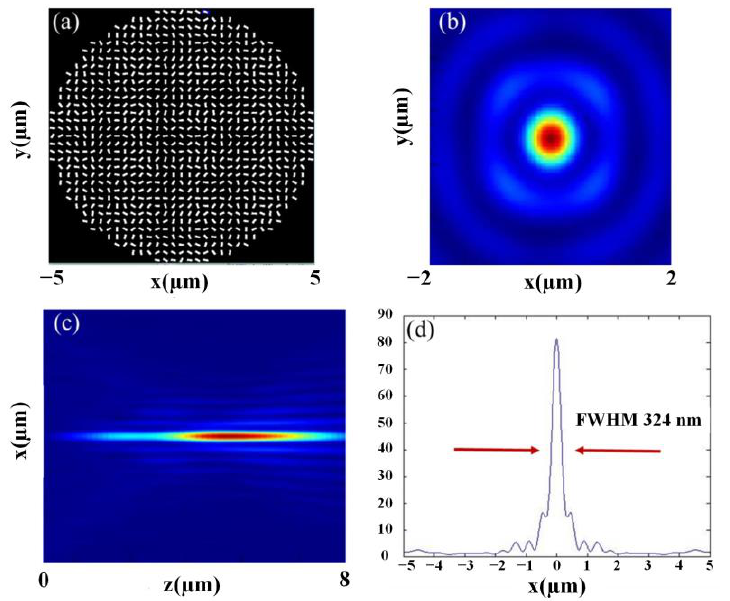
Figure 2. Simulation results of 10 µ m diameter metasurface, NA = 0.7; ( a ) schematic diagram of metasurface; ( b ) optical field distribution of Bessel beam cross-section; ( c ) x-z plane light field distribution; and ( d ) x -axis intensity distribution curve.